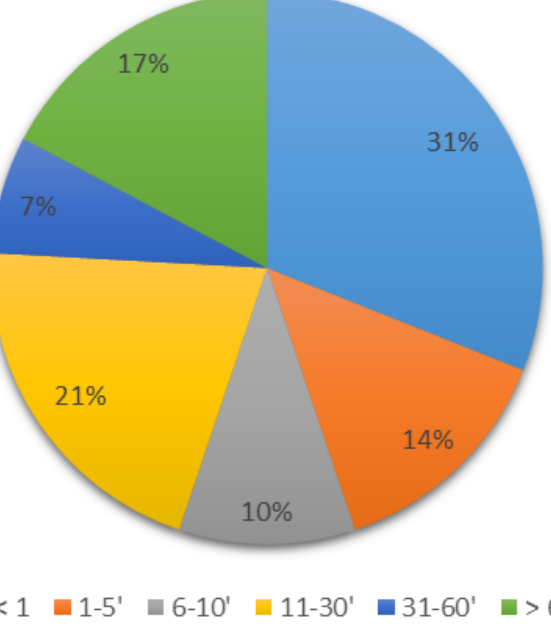
Figure 2. Time taken to observe clinical events after LA injections (min; n = 31).